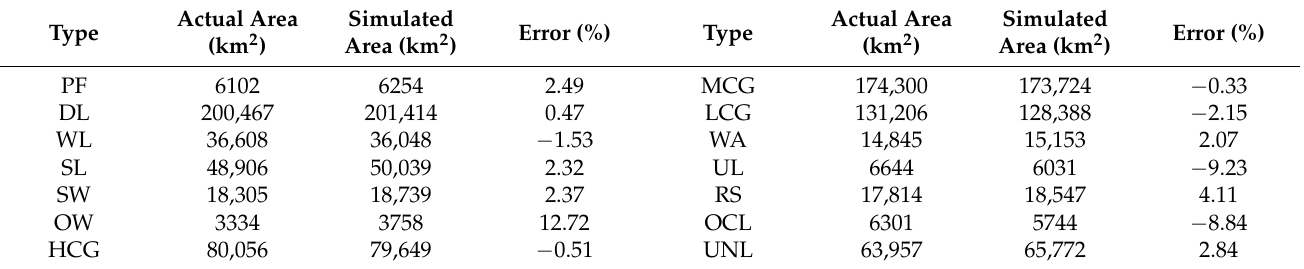
Table 8. Accuracy test of land use simulation in